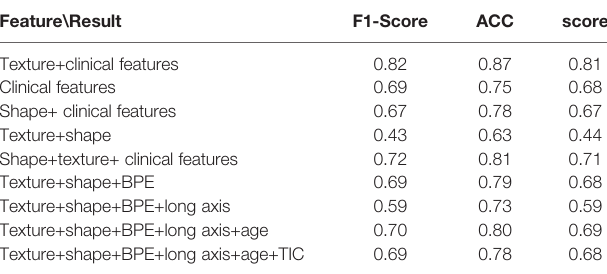
TABLE 3 | The results of ablation